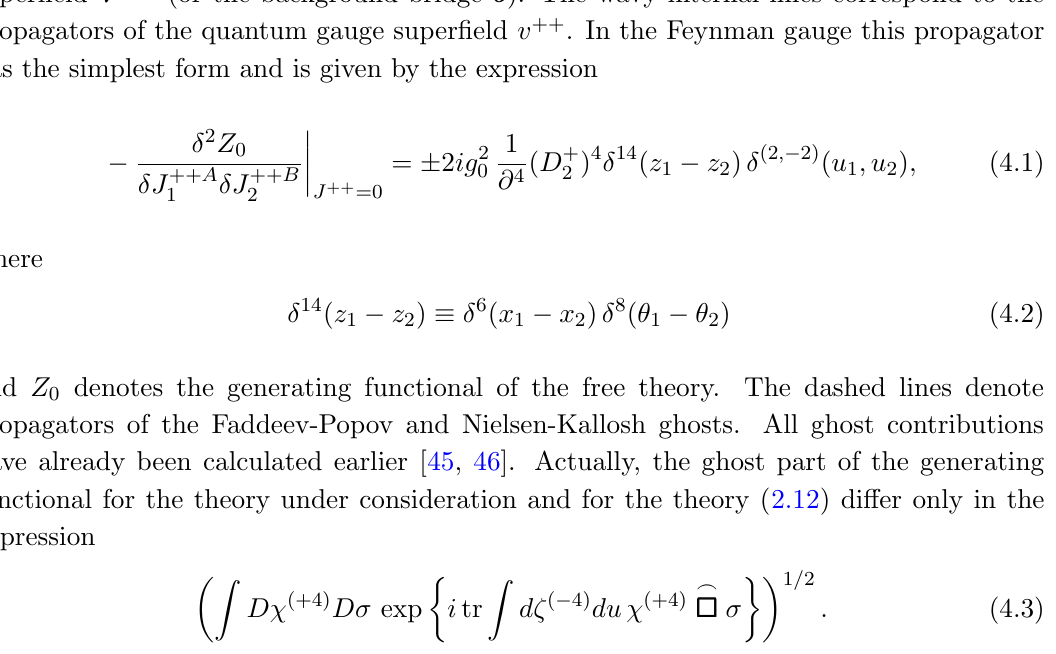
super(cid:12)eld V ++ (or the background bridge b ). The wavy internal lines correspond to